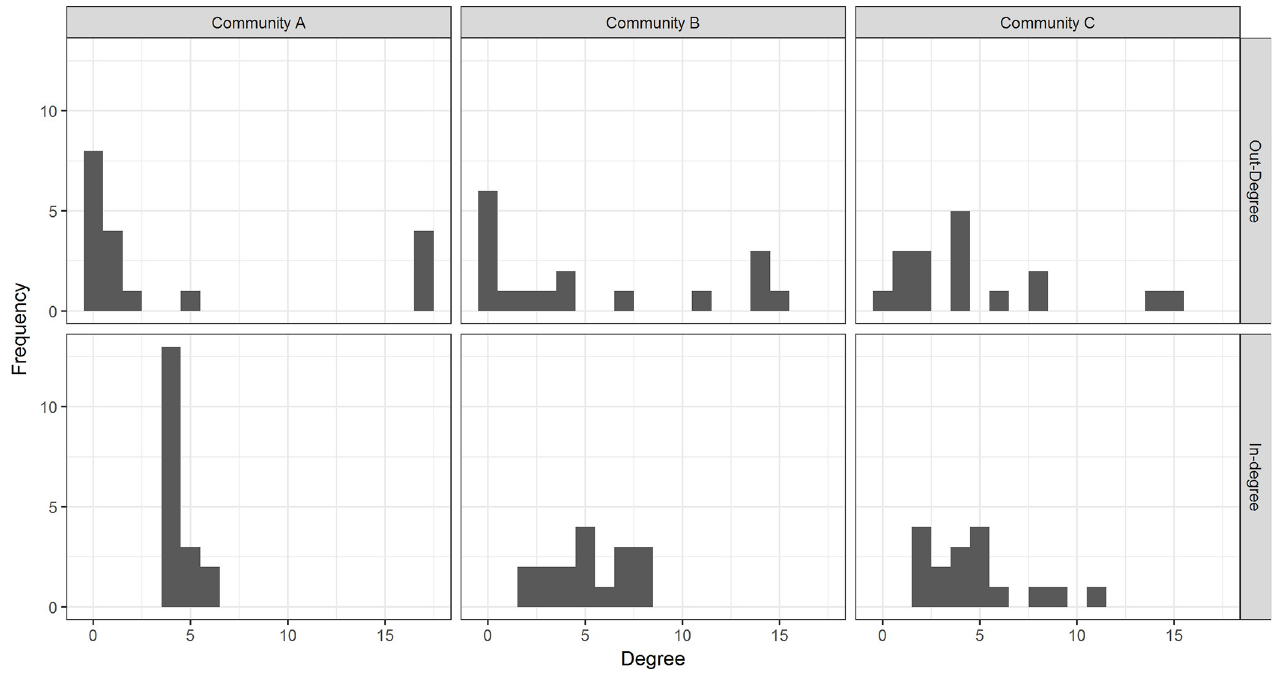
Fig 3. Distributions of out-degrees (upper) and in-degrees (lower) of network nodes from different locations.